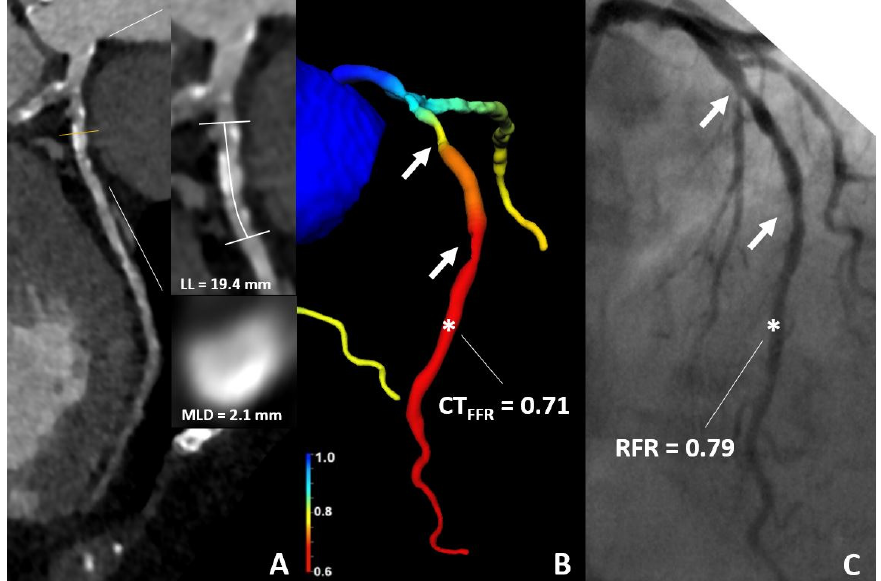
Figure 5. 76-year-old woman. ( A ) CT demonstrates sequential 50% stenoses of the LAD. ( B ) The CT- FFR value was of 0.71 (star). ( C ) ICA confirmed ischemia with an RFR-value of 0.79 (star); RFR Cut- Off ≤ 0.89. CT, computed tomography; CT-FFR, coronary computed tomography angiography based fractional flow reserve; RFR, resting full cycle Ratio; LL, lesion length; MLD, minimal luminal diameter.